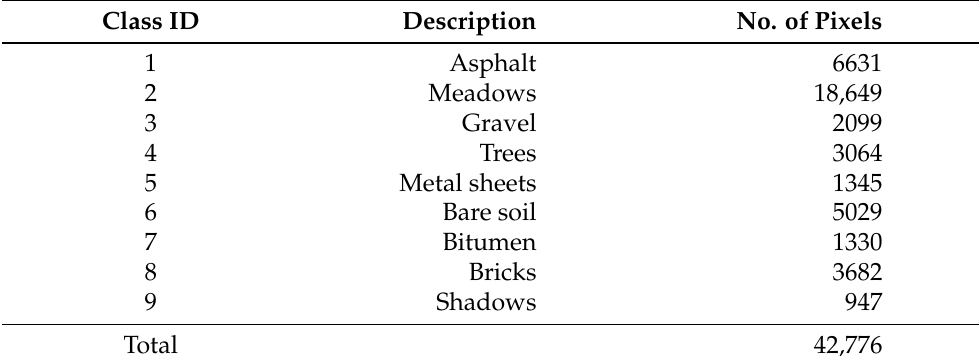
Table 2. The number of samples (pixels) for each class in the Pavia University dataset.